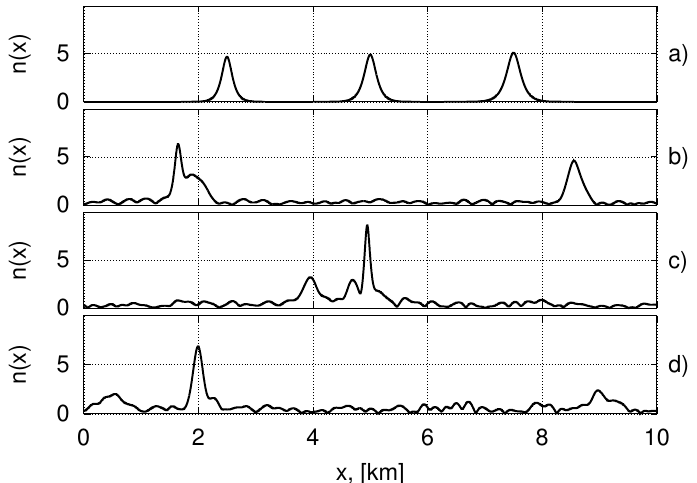
Figure 5. The evolution of three interacting breathers. The ordinate shows the particles number density n ( x ) . The top panel ( a ) presents the initial state ( t = 0 s). Panels ( b ) and ( c ) correspond to the states with t = 5.48 × 10 5 s. and t = 1.55 × 10 6 s. The lower panel ( d ) presents the state where the only one soliton remained ( t = 2 × 10 6 s.)